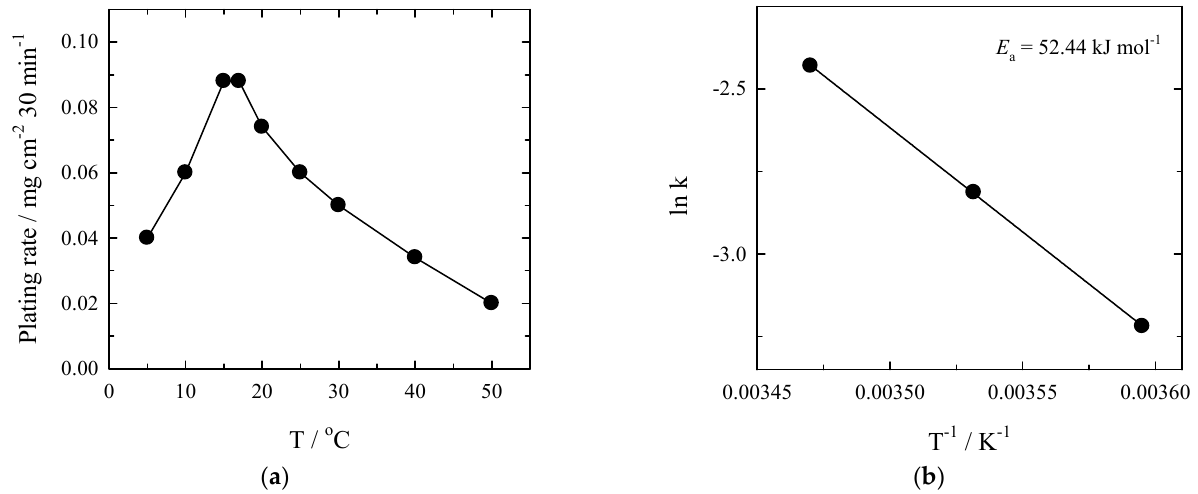
Figure 6. ( a ) Effect of temperature on the rate of electroless Pt plating under conditions with Ar bubbling. The solution composition is the same as in Figure 2. ( b ) The Arrhenius plot calculated from Pt deposition rates for the first three points in the same